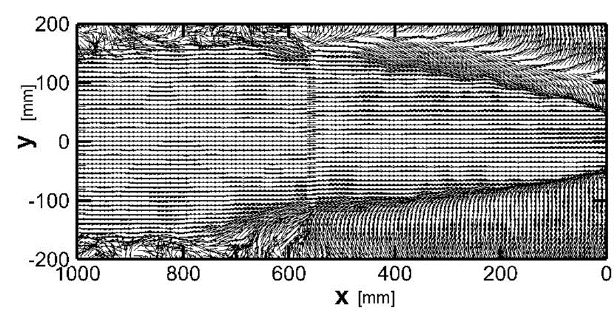
Fig. 3 . The image of the measured velocity field. For the case: 60 o diffuser and flow rate 380 m 3 /h.